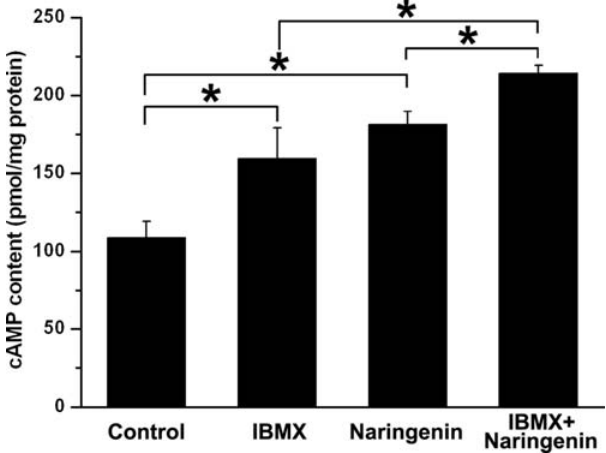
Figure 5. Effect of NAR on intracellular cAMP level of rat colonic mucosa. Comparison of the cAMP generation induced